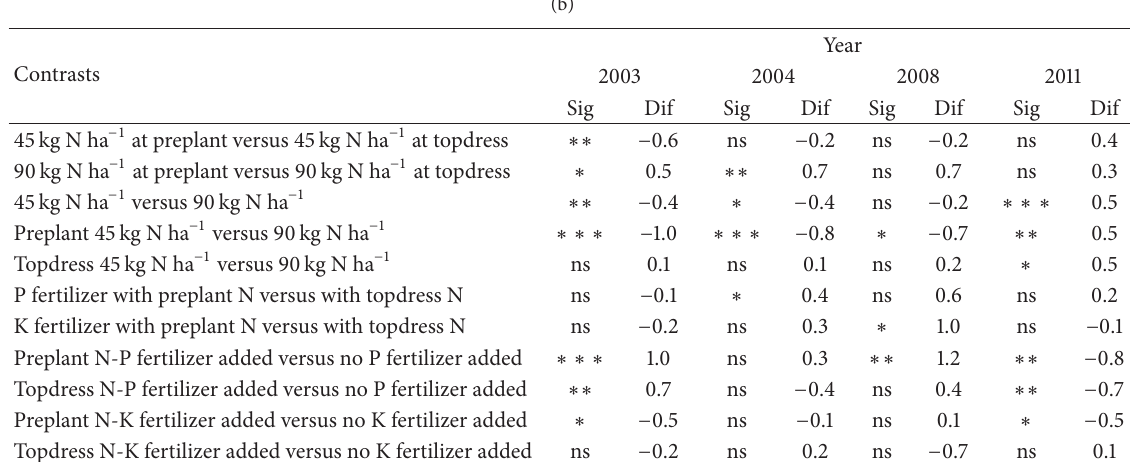
a Standard error of the difference for the interaction of N application timing and fertilizer treatment. ∗ and ∗∗ are significant at the 0.1 level and 0.01 level, respectively. ns: not significant at the 0.1